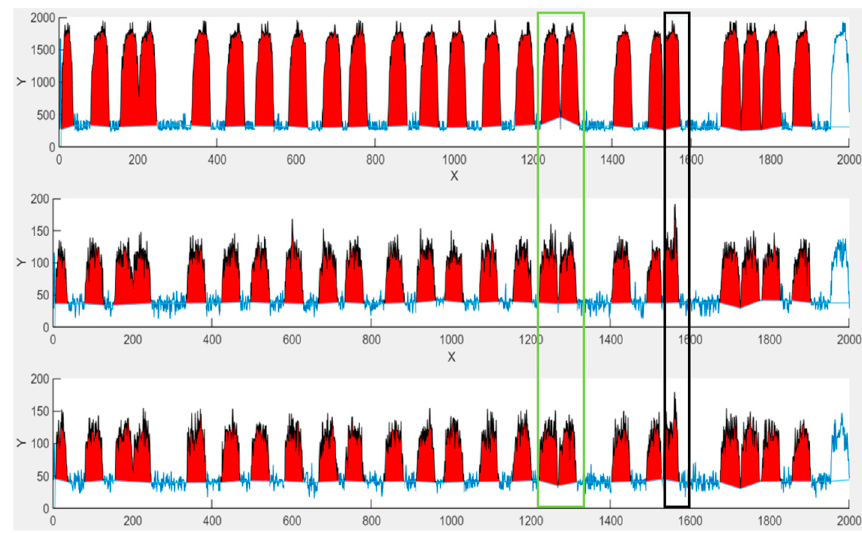
Figure 9. Section of the peak evaluation of the double emulsions at the 5% filling degree. The top column shows the peaks of the oil phase, the middle column those of the inner water phase, and the bottom column those of the reference.